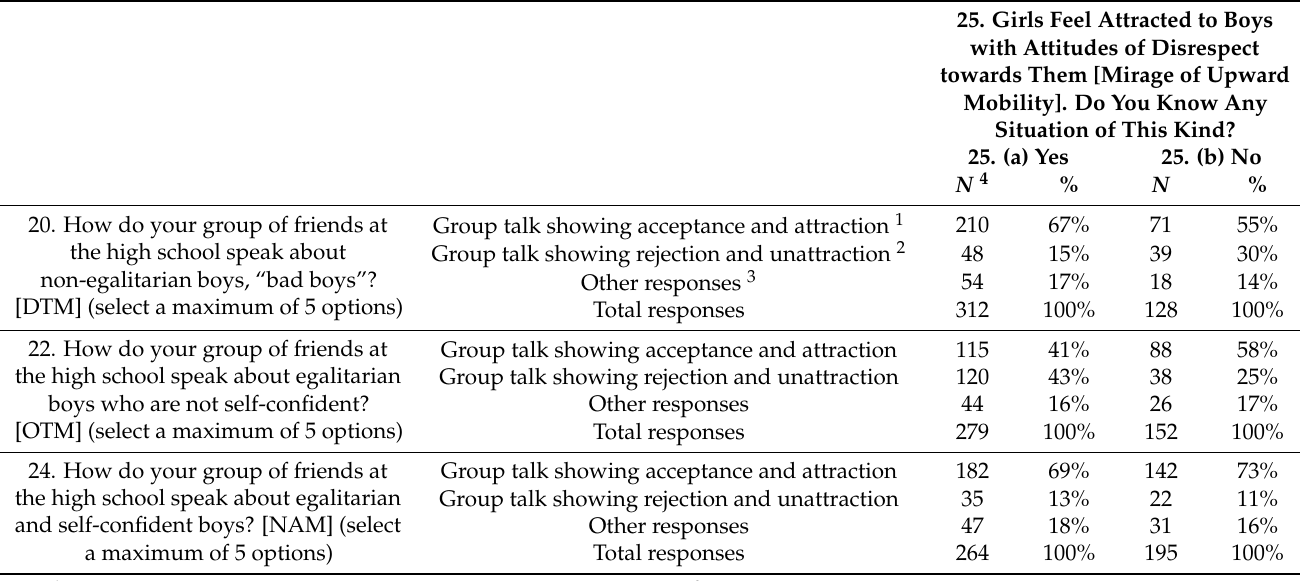
Table 3. Peer group talk about types of masculinity and mirage of upward mobility on